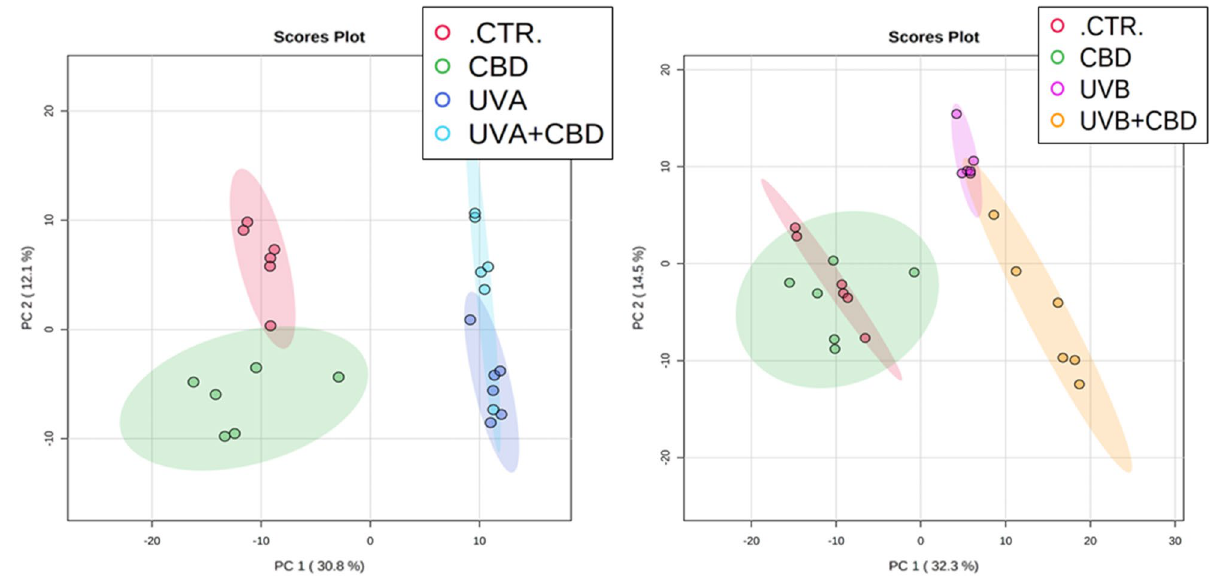
Figure 2. Principal component analysis (PCA) of plasma proteins from the control rats (CTR) and animals topically treated with cannabidiol (2.5 g CBD in 100 g petrolatum) and/or irradiated with UVA (increasing doses from 0.5 to 5 J/cm 2 ) ( A ) or UVB (increasing doses from 0.02 to 2 J/cm 2 ) ( B ). ssStatistical analysis were performed using open-source software MetaboAnalyst 5.0 (www. metab oanal yst. ca).